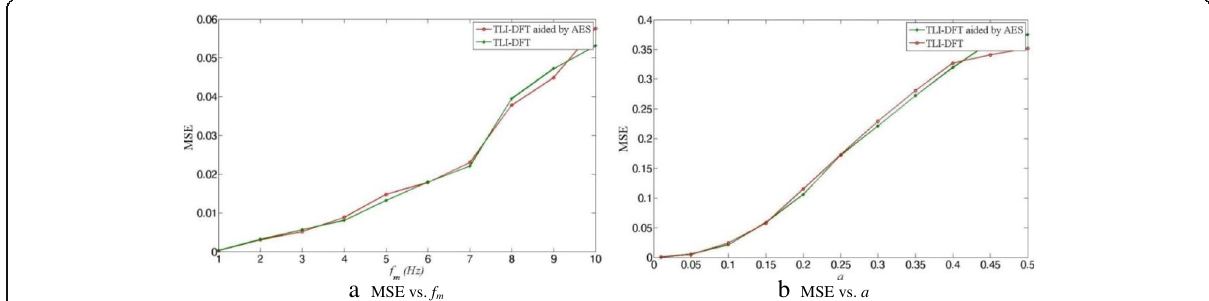
Fig. 11 Performance of TLI-DFT with or without AES algorithms in scenario 2 (iterative process stops at third iteration, a = 0.04, f m = 2 Hz)